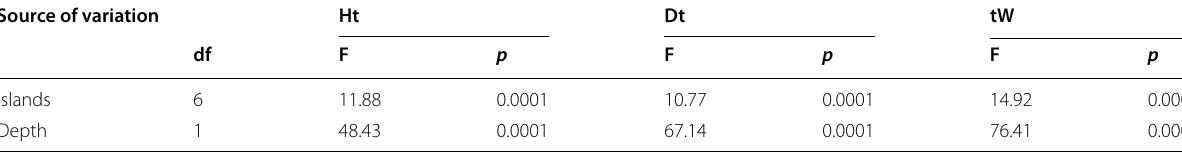
Table 2 ANOVA results of the spatial effects on biometry (Ht test height, Dt test diameter,) and biomass (tW total weight) of the = = = surveyed Diadema setosum population in the Dodecanese island complex (south Aegean Sea) Source of variation Ht Dt tW df F p Islands 11.88